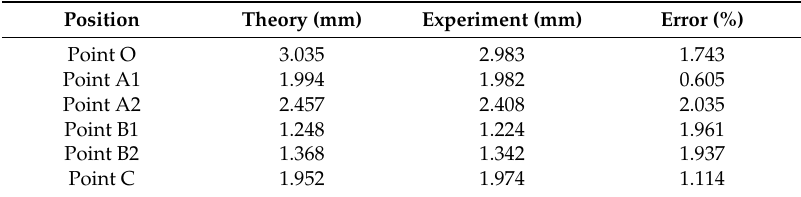
Table 4. Comparison of mean value of displacement at measurement Table 5. Comparison of variance value of displacement at measurement points.